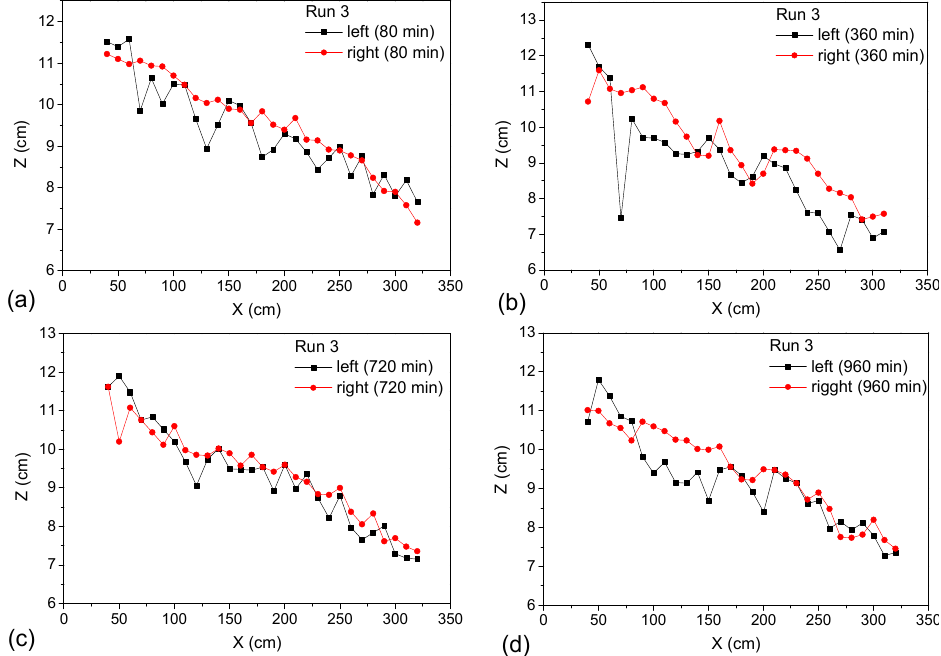
Figure 15. Longitudinal variation of near-bank bed elevation for unilateral riparian vegetation cover and with 80% vegetation coverage ( a ) t = 80 min, ( b ) t = 360 min, ( c ) t = 720 min and ( d ) t = 80 min.